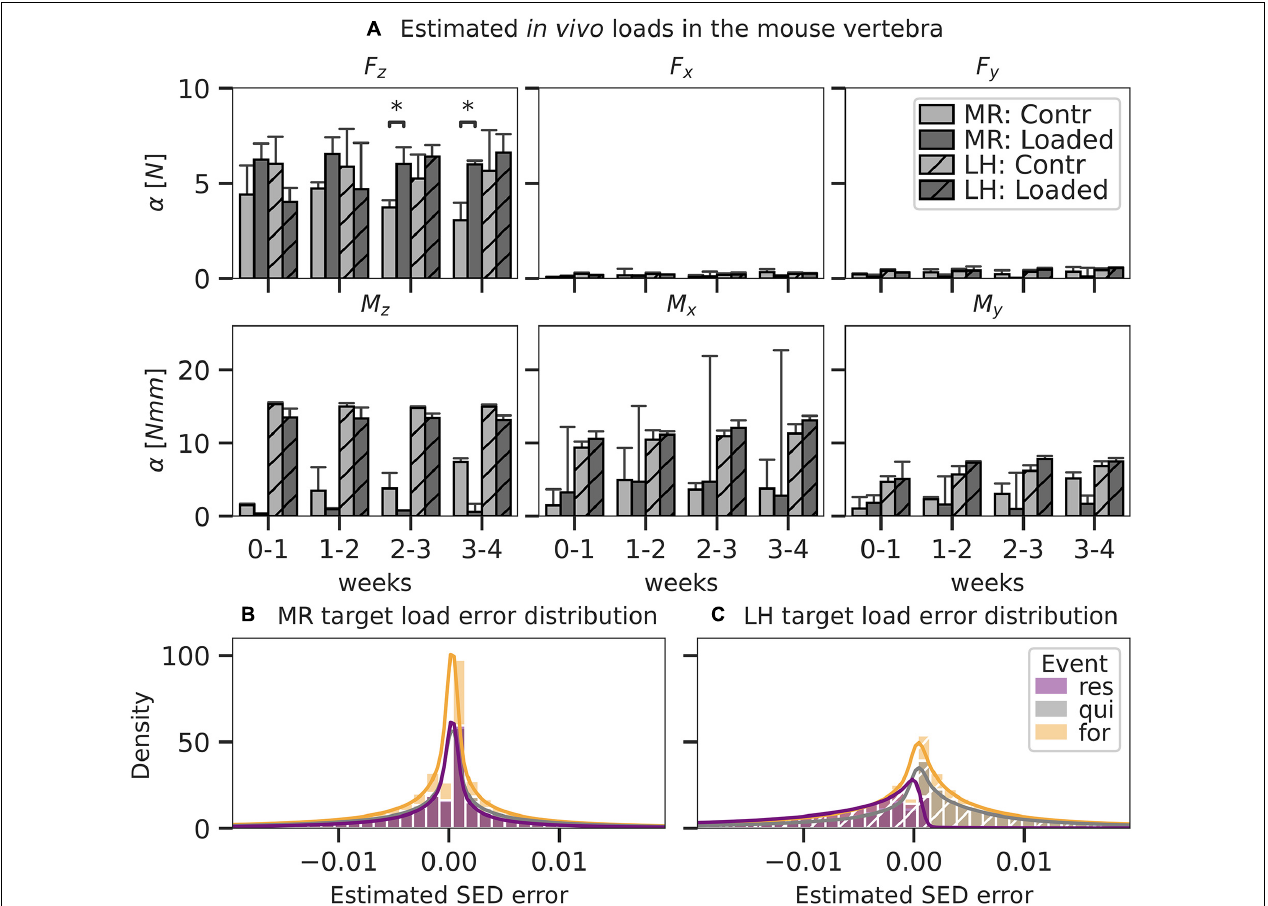
FIGURE 5 | Load components and error as predicted by mechanoregulation-based load estimation (MR; solid) and load history (LH; dashed) for mouse caudal vertebra ( n = 8) subjected to physiological (Contr) and extra-physiological loading (Loaded). Bar plots in panel A show mean predicted load and standard error (SE) for each component of a 6DoF. Significant differences in prediction between MR and LH with p < 0.05 are indicated ( ∗ p < 0.05; Mann–Whitney–Wilcoxon, Bonferroni). By MR and LH, predicted strain energy density (SED) distributions were compared to an anticipated target load case and distribution was derived from the experimental conditions (contr: 4 N in Fz, loaded: 8 N in Fz). Local error distribution was assessed between estimated and target SED for MR (B) and LH (C) and grouped in regions of formation, resorption, and quiescence, as derived from time-lapsed micro-CT images. Histograms were truncated at the 98th percentile SED